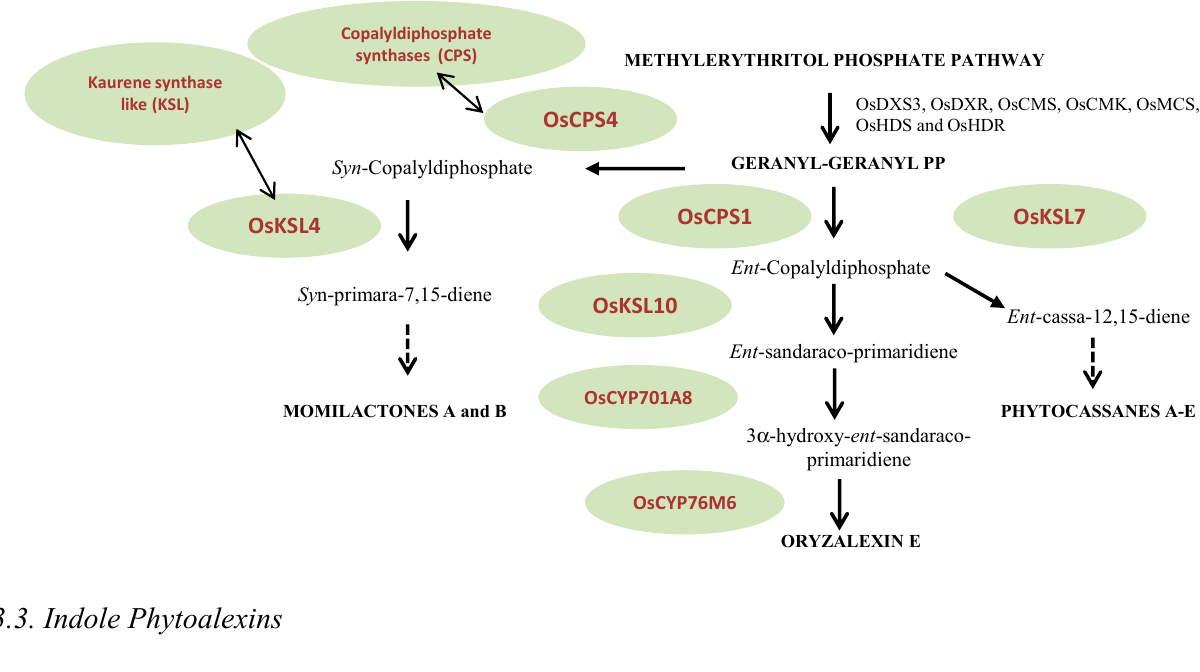
Figure 2. Biosynthetic pathway of diterpenoid